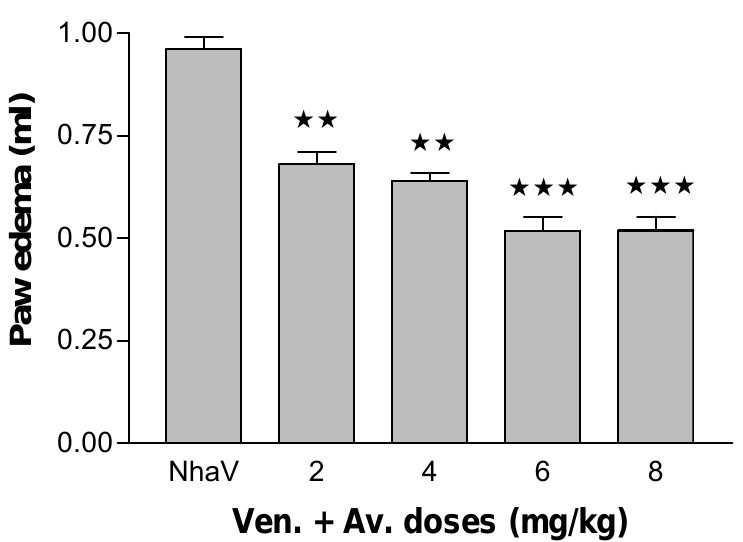
Figure 4: Edematous effects on rat paw by coupling and incubating the antivenom (0.4, 0.8 and 1.6mg/kg) with NhaV (5µg/paw) for 30 min The control group received NhaV alone (5µg/paw), instead of drugs, in the same experimental conditions. Each column represents the mean ± S.E.M. of six